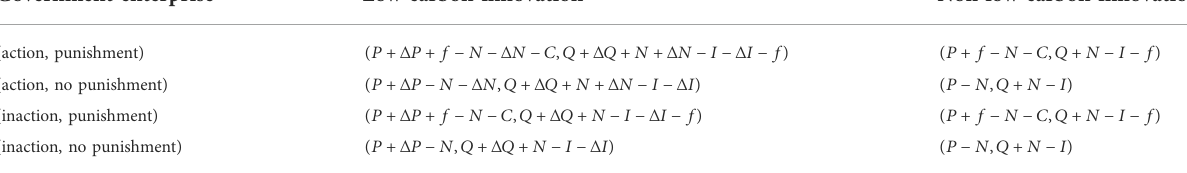
TABLE 1 Enterprise-government carbon game income